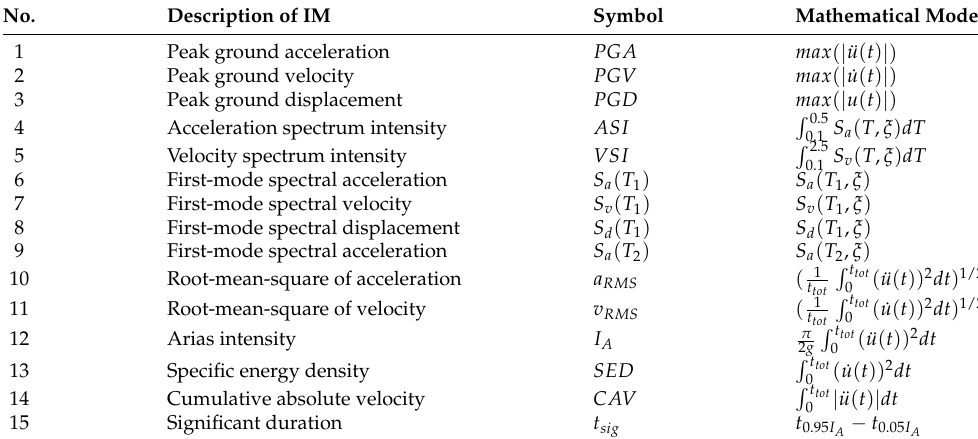
Table 1. A list of ground motion IMs